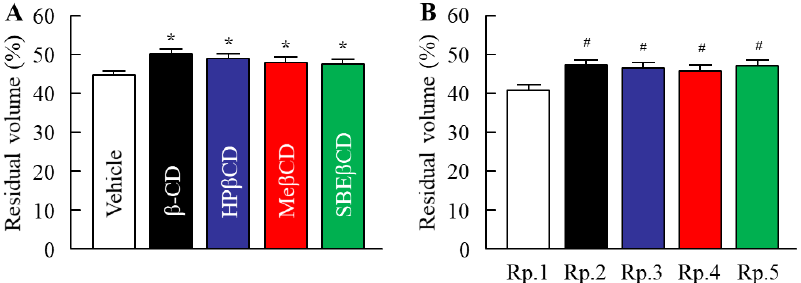
Figure 4. Effect of each CD on the volatile volume of the DEET/EtOH/CD formulations. ( A ) Changes in volatile volume of the various 0.1% CDs solutions. ( B ) Changes in volatile volume in the DEET/EtOH/CD (10:40:0.1,%) formulations (Rp. 1 – 5 formulations). The compositions of DEET/EtOH/CD formulations (Rp. 1 – 5 formulations) are shown in Table 1. n = 8. * p < 0.05 vs. Vehicle. # p < 0.05 vs. Rp. 1 formulation. The volatile volume of DEET/EtOH formulations was decreased by the addition of 0.1% CDs.